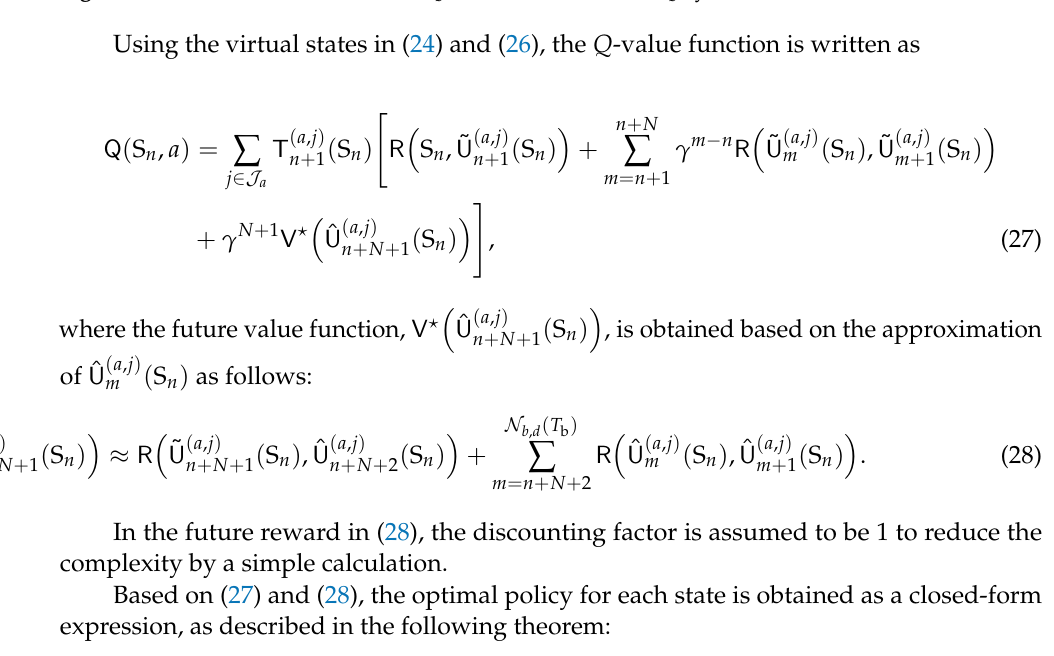
Figure 4. d -th data block consists of N b data subblocks with T b